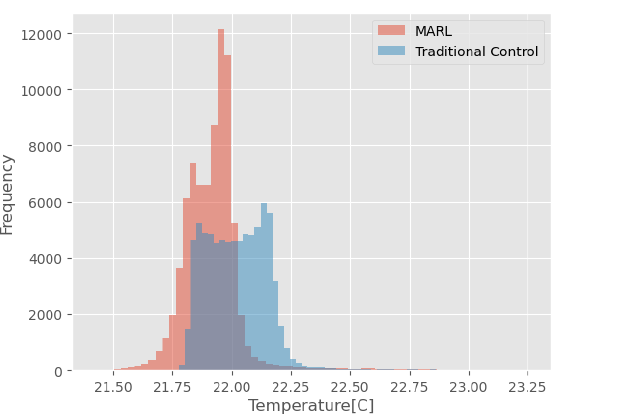
Figure 10. Histogram of room temperature in zone #1 from simulation with four temperature